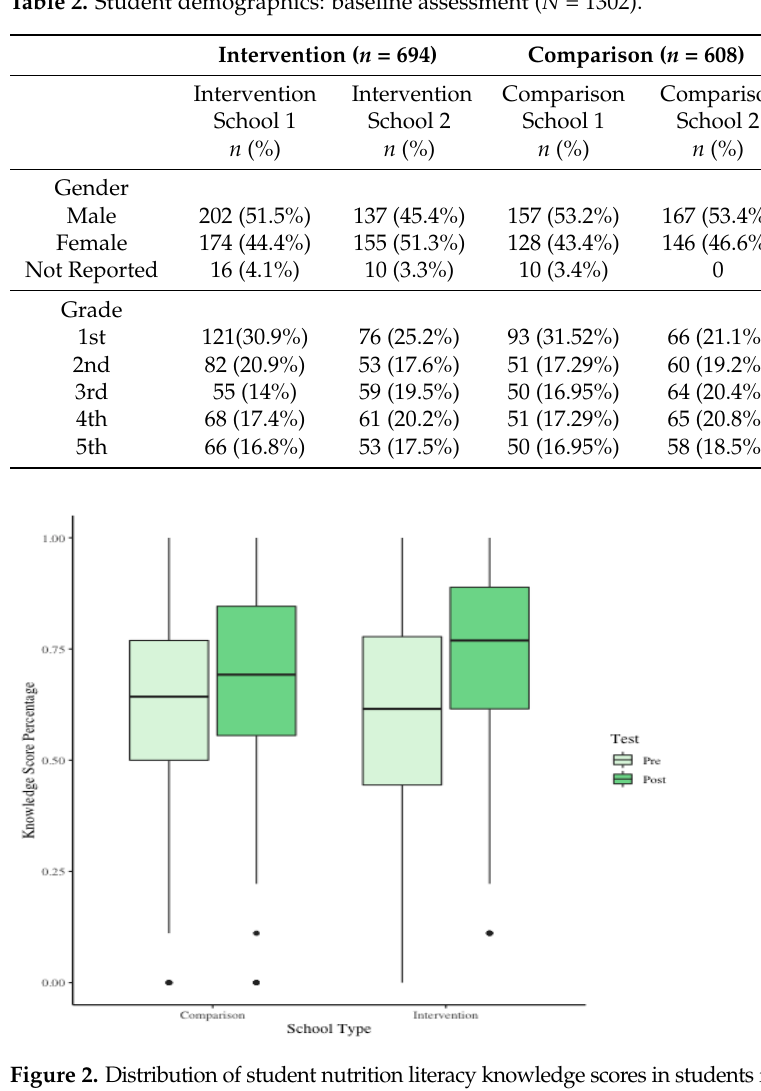
Figure 2. Distribution of student nutrition literacy knowledge scores in students first year of the program .